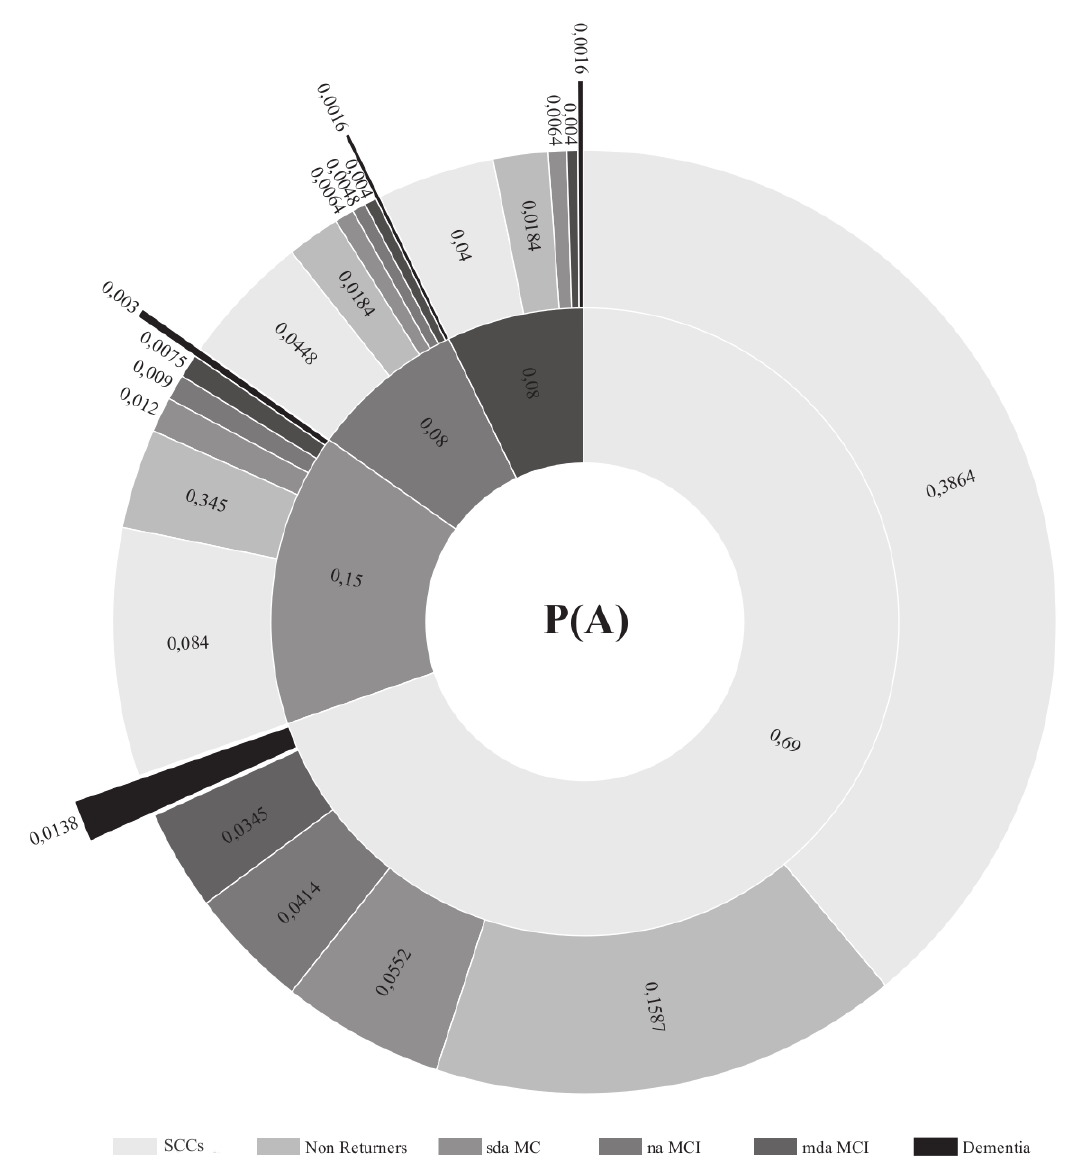
Figure 1. Diagnostic probabilities at baseline (inner circle) and at first follow-up (outer circle). Diagnostic probabilities are presented numerically, as proportions, with the total sum of proportions in the inner and outer circles equaling 1. The naMCI group is absent from the outer circle, but corresponds to the mdaMCI group in the inner circle as no transitions from mdaMCI to naMCI were recorded. SCCs = Subjective cognitive complaints; MCI = mild cognitive impairment; mda = multidomain amnestic; na = non-amnestic; sda = single domain